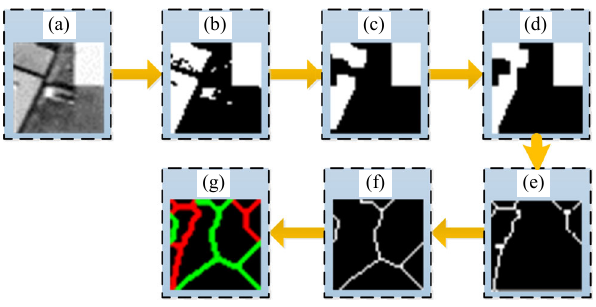
Fig. 5 Process of skeletal structural extraction from the neighboring areas around matching keypoints: (a) original image, (b) threshold segmentation, (c) opening operation, (d) closing operation, (e) skeleton operation, (f) antiskeleton operation, and (g) bright and dark line